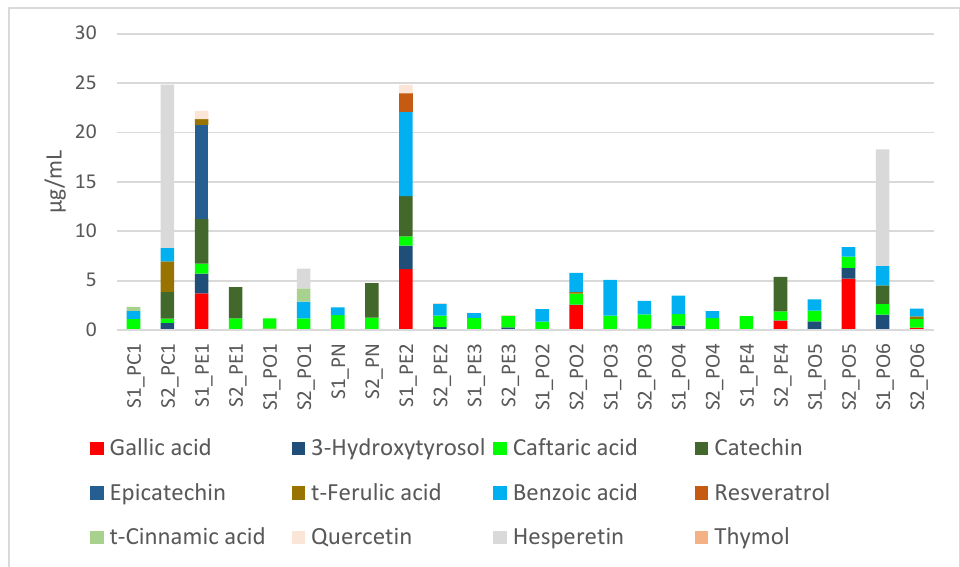
Figure 3. Cumulative distribution of the most abundant phytochemicals in the tested extracts. Table 6. Minimal inhibitory concentrations (MICs) of Pleurotus mycelia (S1) extracts against bacte- ria